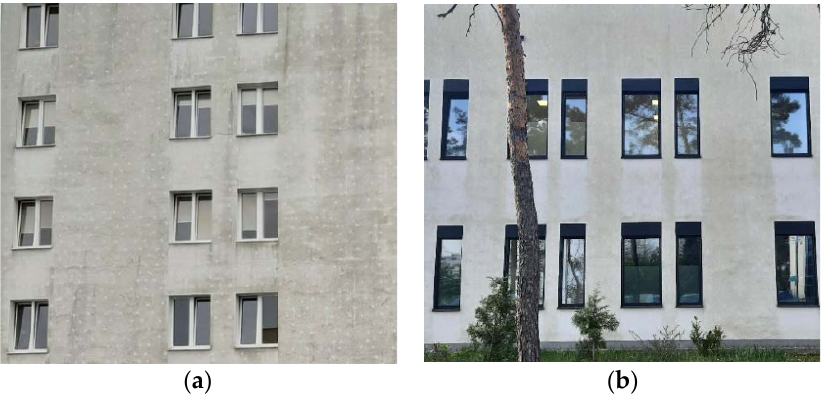
Figure 11. Specific biocorrosion development on exterior wall finish of the same building in operation for 10 years (photo ( a )) and for 5 years (photo ( b )). ( a ) Anchors that completely penetrate the thermal insulation material (author’s archives). ( b ) Anchors embedded into the insulation material (author’s archives).